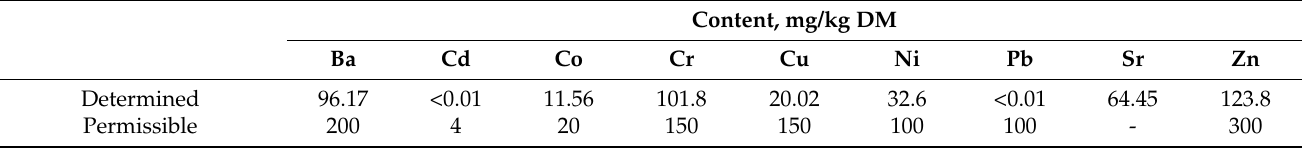
urbanized land, excluding industrial land), according to